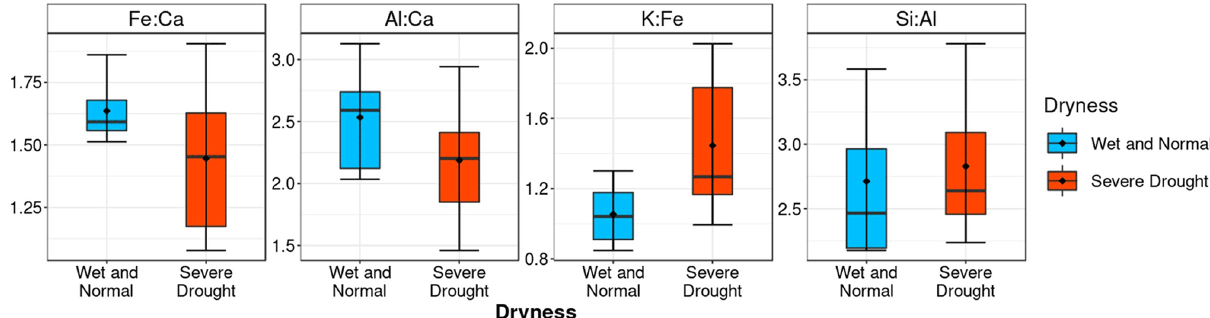
Figure 3. Boxplots of four dust elemental ratios under non-drought (wet and normal) and severe-drought conditions. Observations are from eight IMPROVE sites in the southeast region shown in Fig. 1a. The upper and lower whiskers of the boxplots represent the 9th and 1st quantile, respectively. Black dots indicate the mean values. Detailed values of this figure can be found in Table